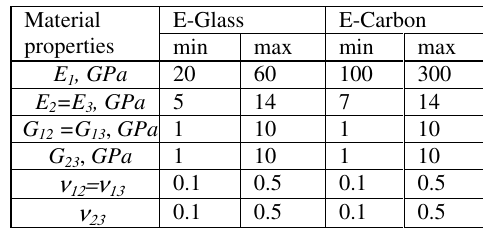
Table 2. Material properties and range of